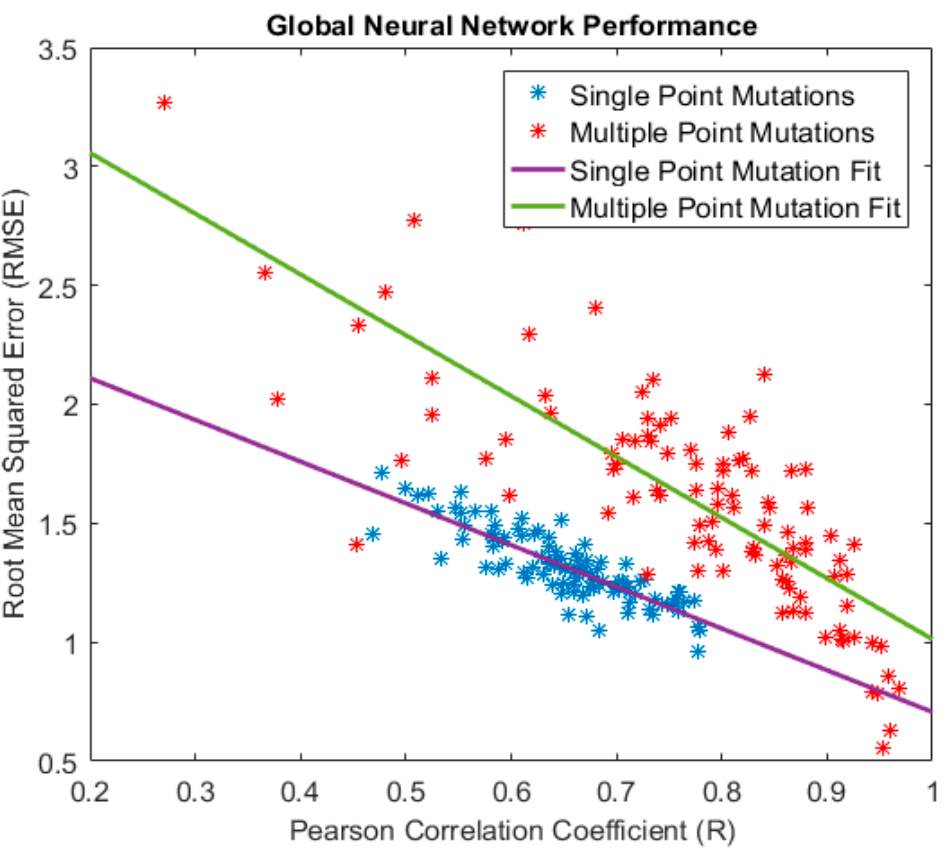
Figure 10. Relationship between RMSE and Pearson Correlation Coefficient for Single and Multiple Point Mutations.